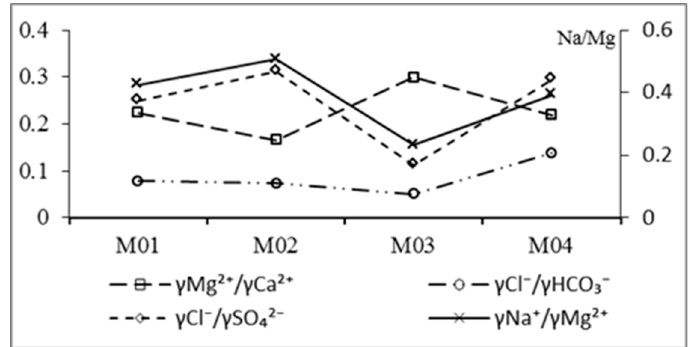
Figure 5. Changes in the proportional coefficients of hydrochemical ions.